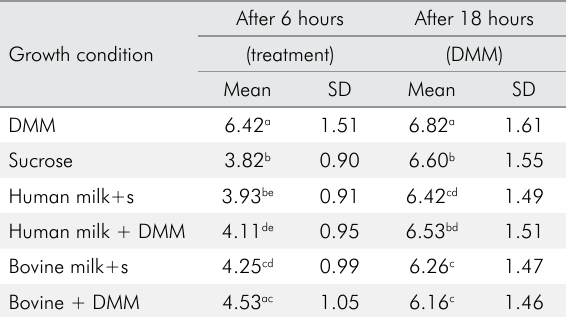
Table. Mean values of supernatant pH according to the growth